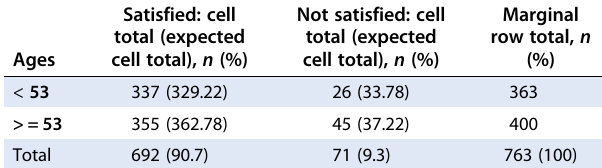
Table 4: Comparison of patient satisfaction by age